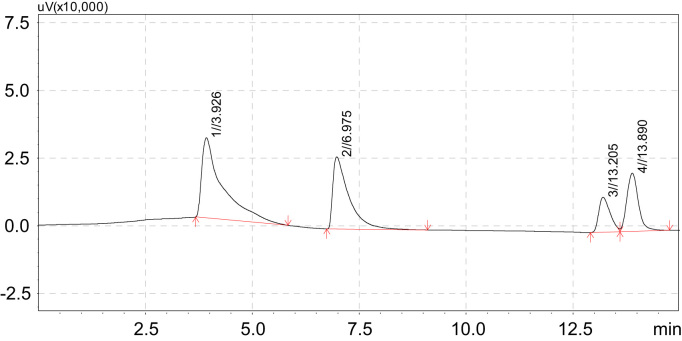
Sample standard.